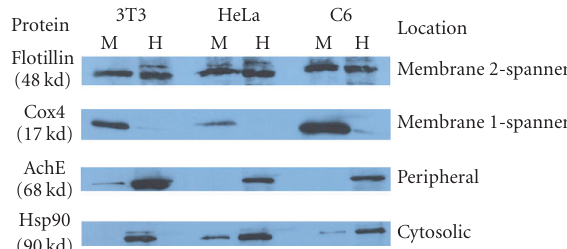
Figure 2. Partitioning of solubilized mammalian membrane proteins using the Mem-PER Kit. Proteins from three cell lines were solubilized and extracted using the Mem-PER Kit. Each set of hydrophilic and hydrophobic (membrane protein) fractions obtained was normalized to one another and analyzed by Western blot for four proteins from the cellular locations noted. PAGEprep resin was used to remove the detergent from the membrane fraction prior to SDS-PAGE/Western analysis of Cox4 due to the interference of detergent with band migration of low molecular weight proteins. A negligible amount of protein was found in all debris fractions (data not shown). Abbreviations: Acetylcholinesterase (AchE), cytochrome oxidase subunit 4 (Cox4), heat shock protein 90 (Hsp90), M = solubilized membrane protein fraction, H = hydrophilic protein fraction.